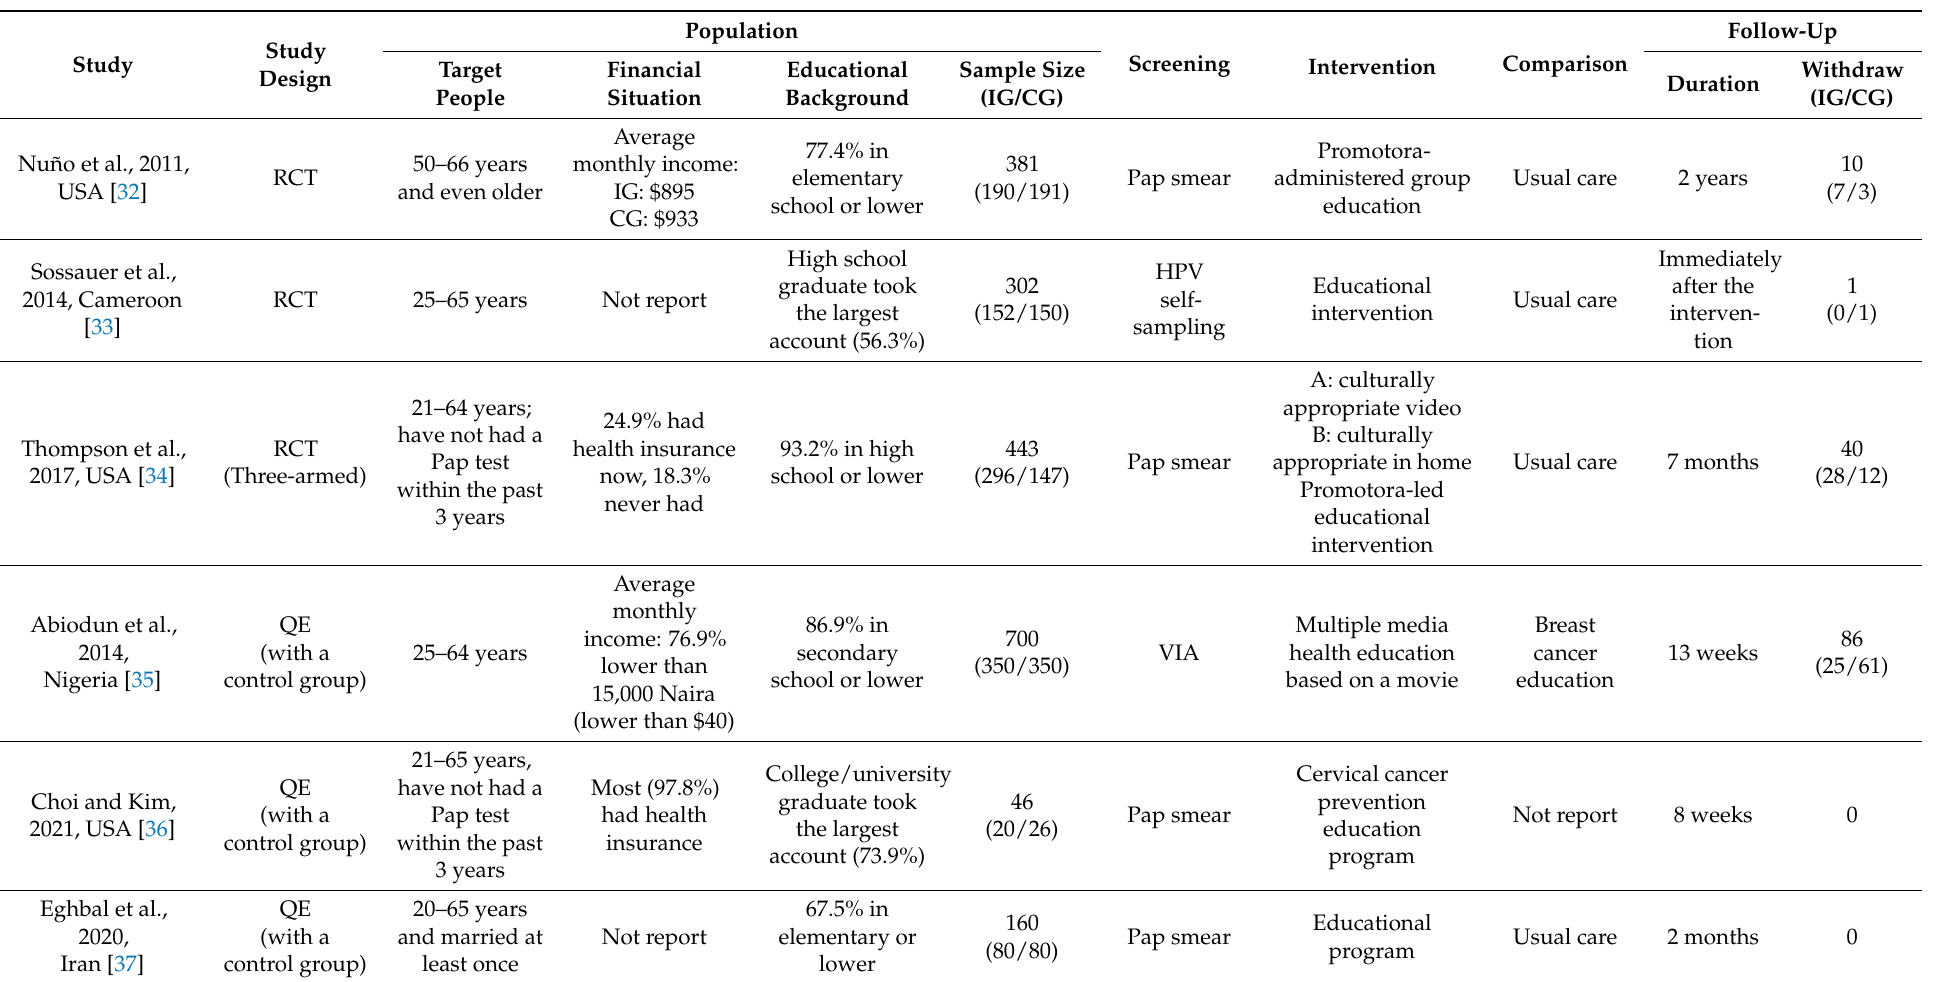
Table 3. Data extraction of the included